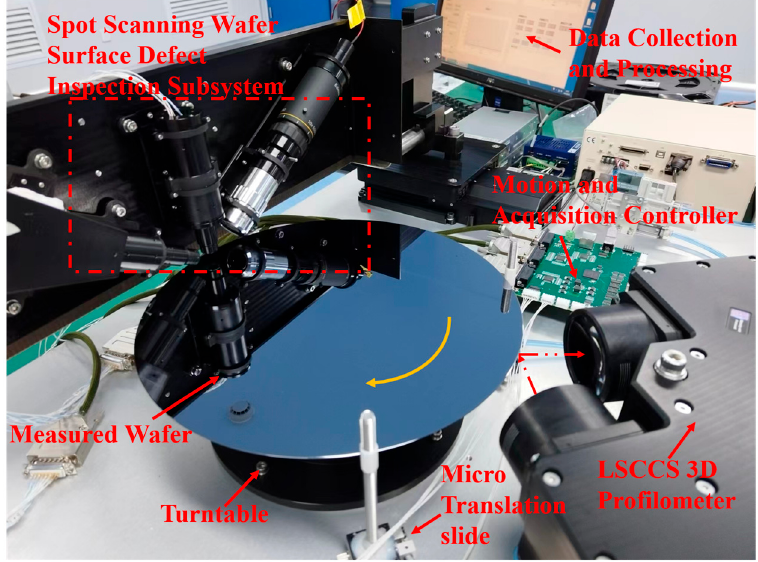
Figure 5. The proposed wafer edge distance measurement